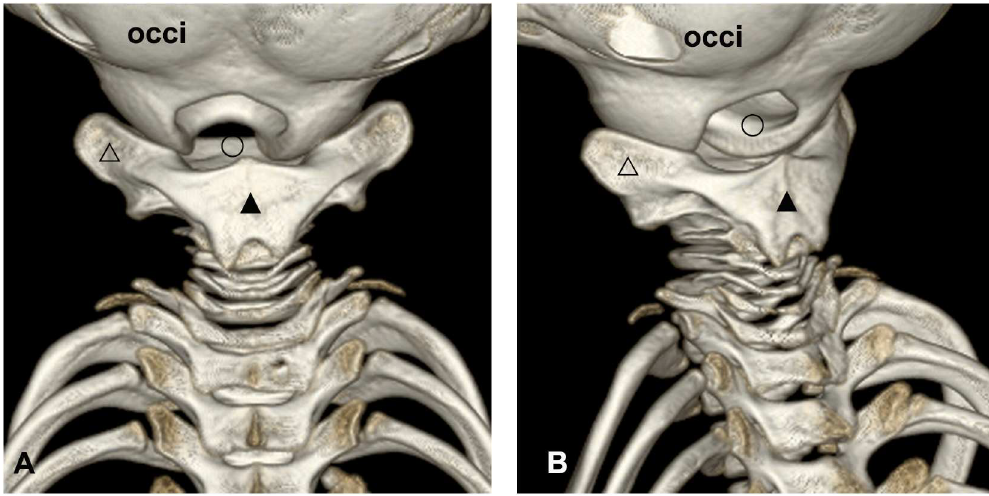
Fig 1. 3D-reconstruction of cranium and cervicalvertebraeof the Neophocaena phocaenoides. A: dorsal view of the suboccipital region. B: left lateral aspect of the suboccipitalregion. occi: occiput. 4 : the fused transverse processeof the first three cervical vertebrae. ▲ : the fused spinousprocesseof the first three cervical vertebrae. (cid:14) : the atlanto-occipital interspace.